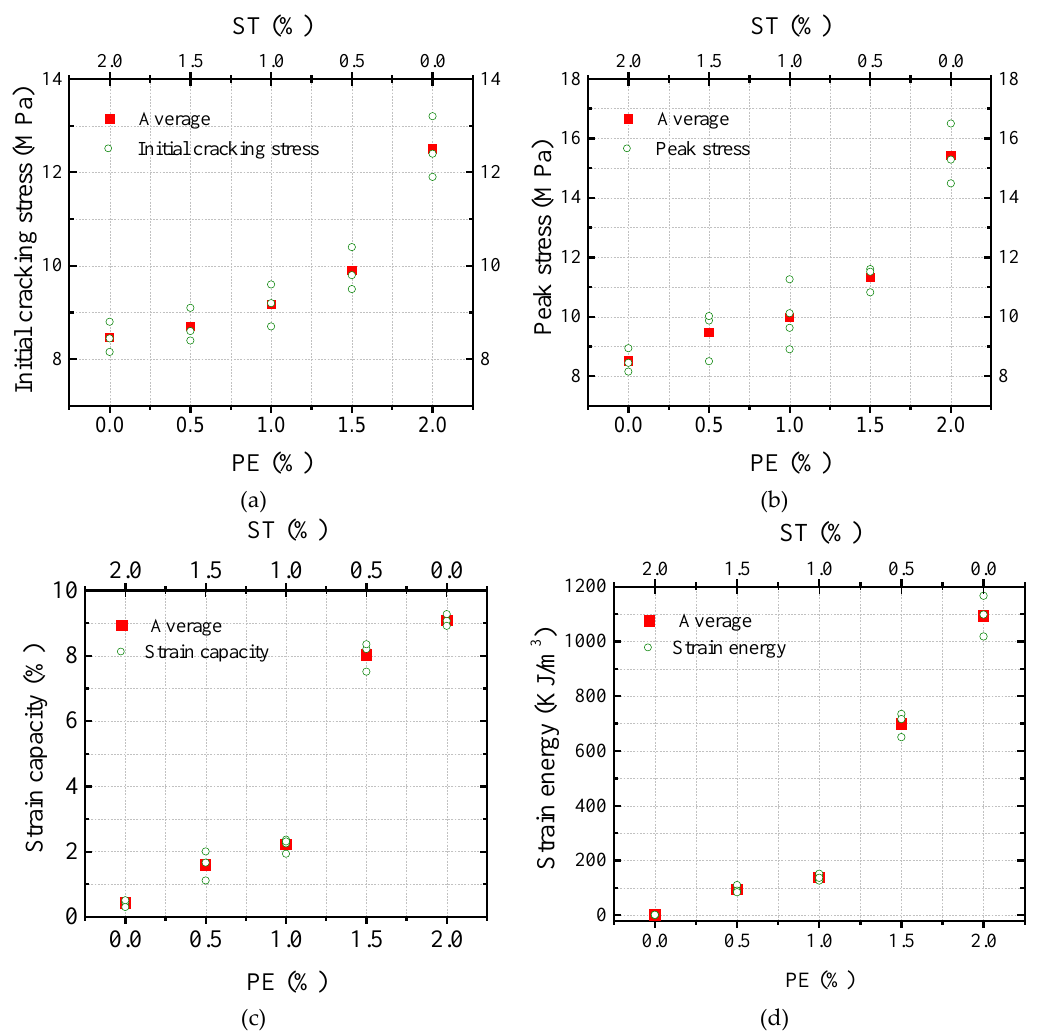
Figure 9. Tensile parameters of HUHP-ECCs. ( a ) Initial cracking stress; ( b ) Tensile strength; ( c ) Tensile strain capacity; ( d ) Strain energy. Materials 2018 , 11, 1448